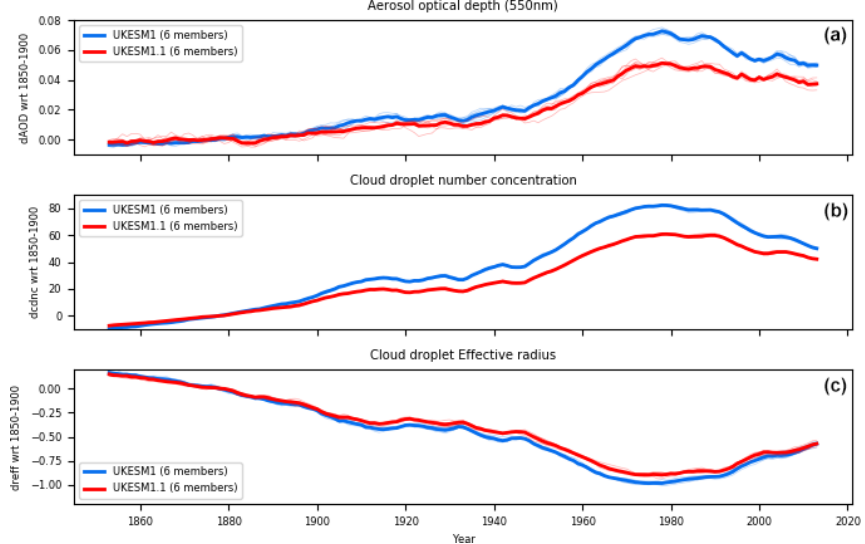
Figure 6. Historical evolution of anomalies in aerosol optical depth (550nm), cloud droplet number concentration and cloud effective radius across the Northern Hemisphere extratropics in UKESM1 (blue) and UKESM1.1 (red). Both cloud droplet number concentration and effective radius represent cloud-top values, and anomalies are calculated relative to the 1850–1900 mean. Both the ensemble mean (thick lines) and individual ensemble members (fainter lines) are plotted. A 5-year running mean has been applied to the annual mean model output.